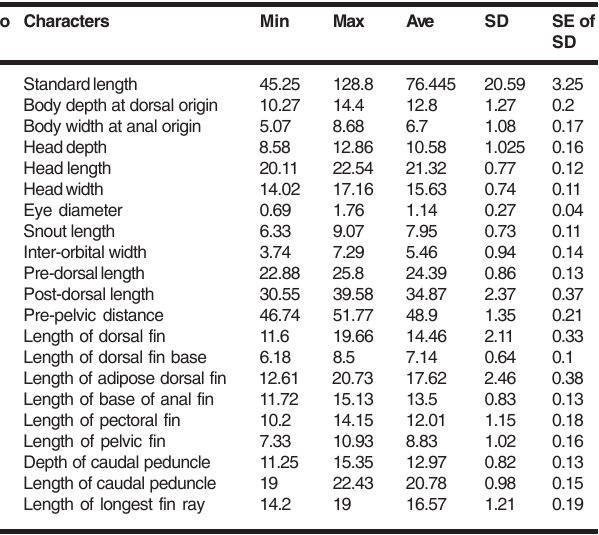
Table 2. Morphometric characters of female in % SL except SL given in mm